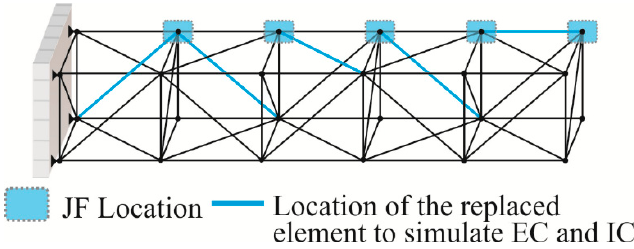
Figure 6. Location of different damage types applied to the truss-type structure.